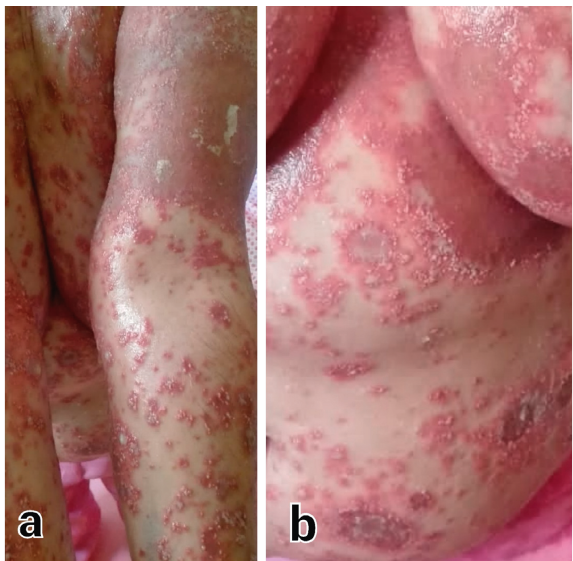
Figure 1: Generalized pustular eruptions with an erythematous base on the body (b) and extremities (a).